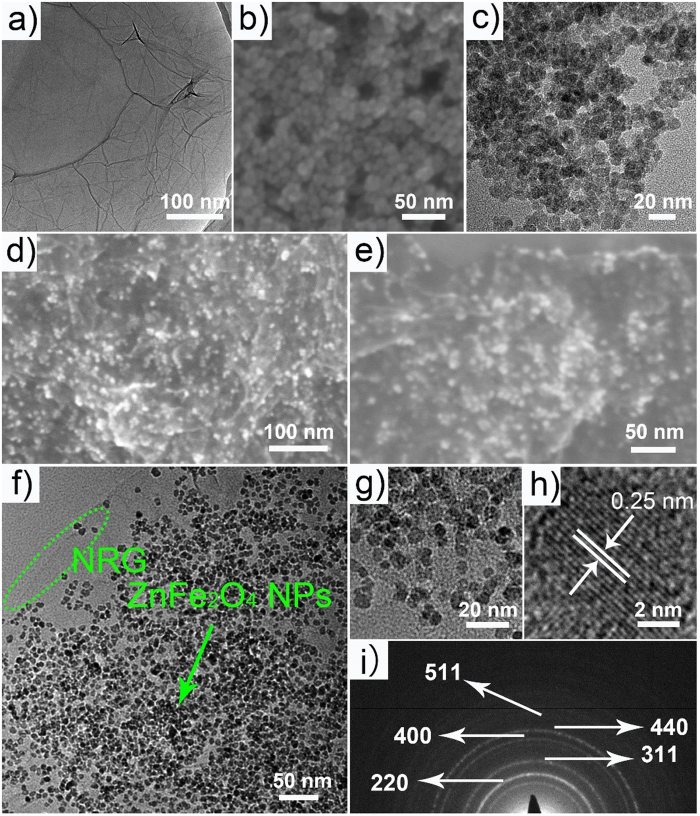
The TEM image of GO (a), the SEM (b) and TEM images of pure ZnFe2O4 NPs (c), Low- (d) and high-magnified SEM image (e), TEM images (f and g), HRTEM image (h) and SAED (i) of ZnFe2O4/NRG composite.